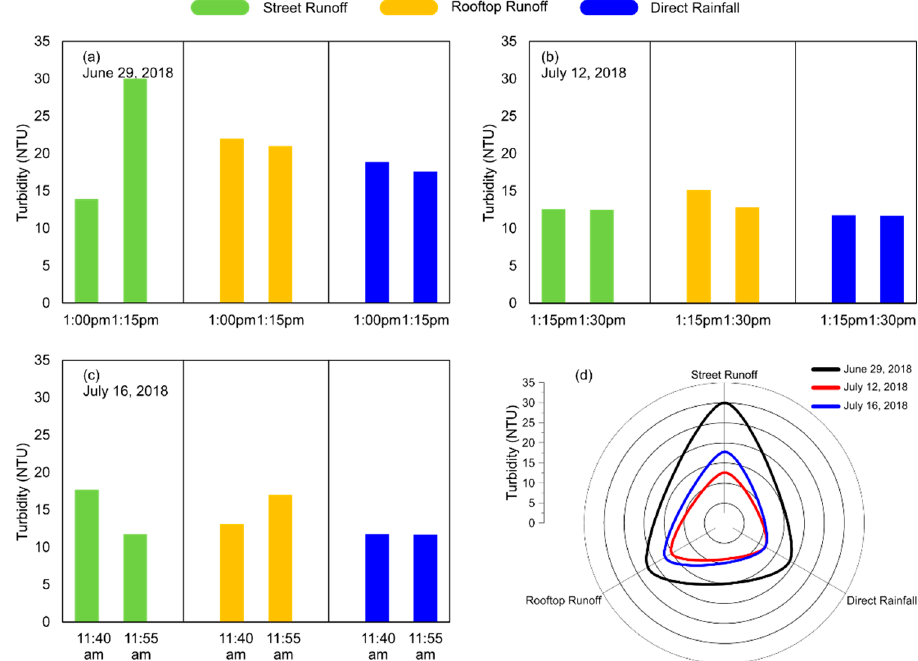
Figure 5. Profile of turbidity (NTU) in harvested rainwater at Site S1—Irrigation Research Institute, Irrigation Department, Lahore, Pakistan, where ( a ) represents 29 June 2018, ( b ) represents 12 July 2018, ( c ) represents 16 July 2018, and ( d ) illustrates comparative analysis of the three selected dates on polar chart.